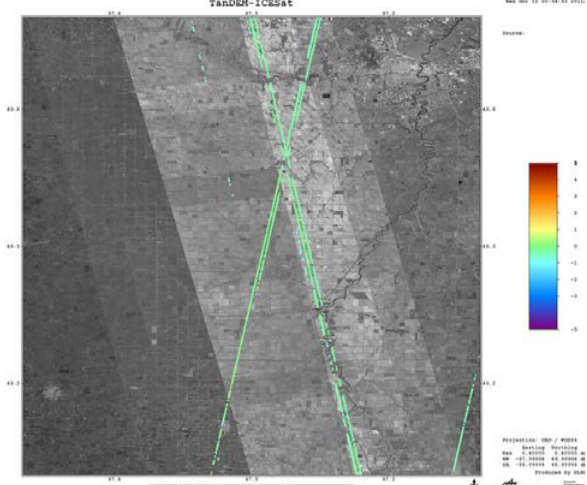
Figure 3: Difference between TanDEM-X and ICESat on amplitude mosaick, tile N49W98, range of values [-5; Table 1: Differences of IDEM tile N49W98 to reference data (mean, standard deviation, linear 90% point-to-point error, number of points)